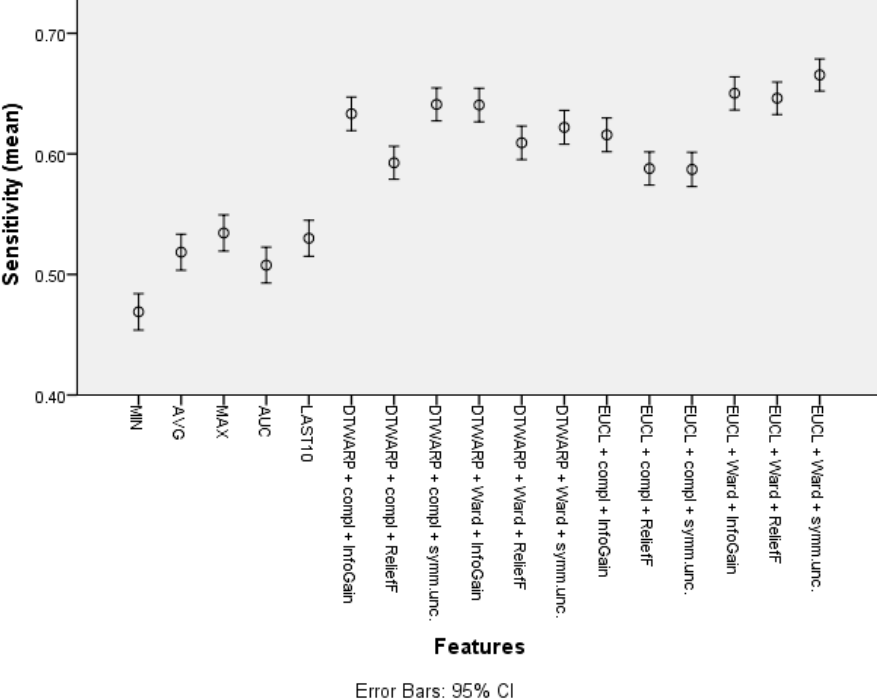
Figure 6. Sensitivity of Naïve Bayes classifiers: mean values and 95% confidence intervals.